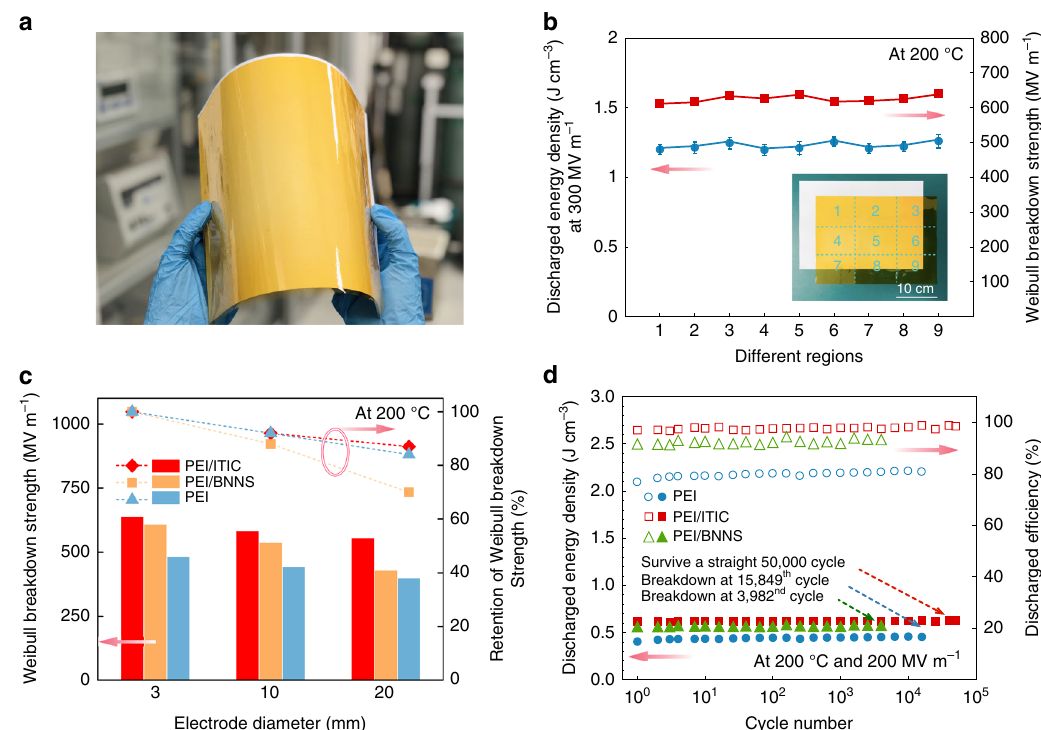
Fig. 4 Reliability and stability evaluations. a Photograph of a PEI/ITIC composite fi lm (0.25 vol.% ITIC) of 20 × 30 cm 2 area. An A4 paper sheet is stacked underneath the fi lm as a reference. b Characteristic breakdown strength and discharged energy density tested at different regions (as marked in the inset photograph) of the large PEI/ITIC fi lm at 200 °C. The average values and max – min error bars of the results were obtained from fi ve parallel samples. c Characteristic breakdown strength and the retention rate with increasing the electrode diameter at 200 °C of PEI, PEI/ITIC (0.25 vol.% ITIC) and PEI/ BNNS (10 vol.% BNNS). d Cyclic performance of PEI, PEI/ITIC (0.25 vol.% ITIC) and PEI/BNNS (10 vol.% BNNS) measured with 20-mm-diameter electrode at 200 °C and 200 MV m − 1 electric fi